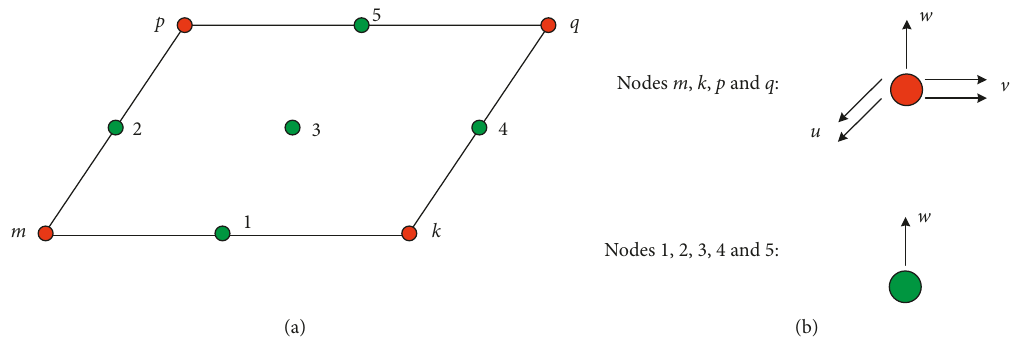
Figure 6: Analysis of DOF for the proposed new plate finite element for the single-layer plate. (a) Proposed new plate finite element for the single-layer plate. (b) Analysis of DOF for each node for the single-layer plate.